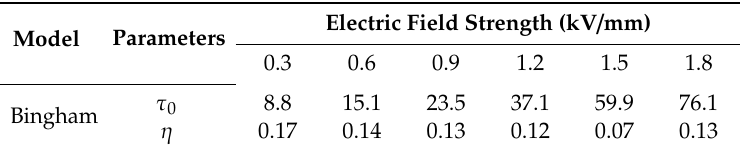
Figure 8. ( a ) Storage (closed) and loss (open) modulus vs. strain curves and ( b ) storage (closed) and loss (open) modulus vs. angular frequency curves of the GO/PDPA microsheet composites-based ER fluid (10 vol.%) with different electric fields. Table 2. Optimal values for Bingham model on the basis of the flow curves for GO / PDPA composites-based ER fluid (10